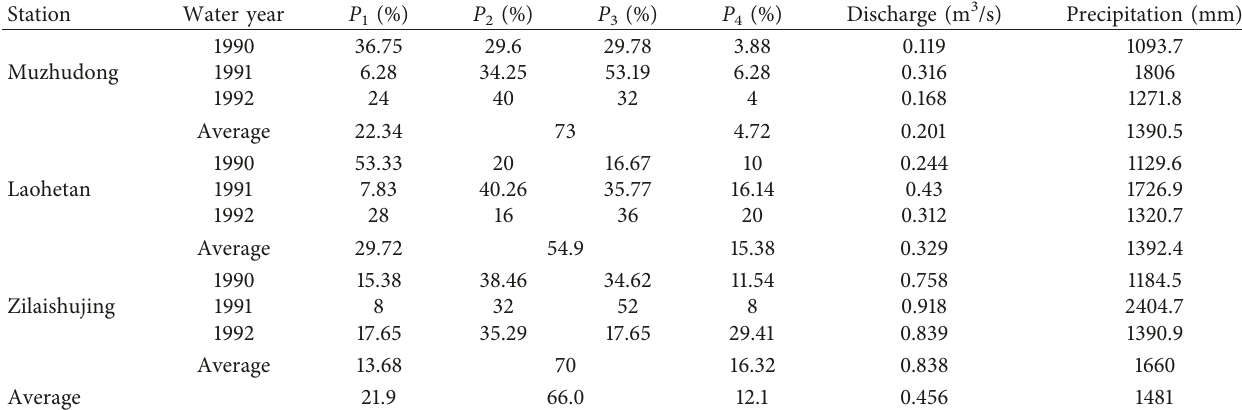
Table 1: The relative contribution of the different runoff components of three stations.